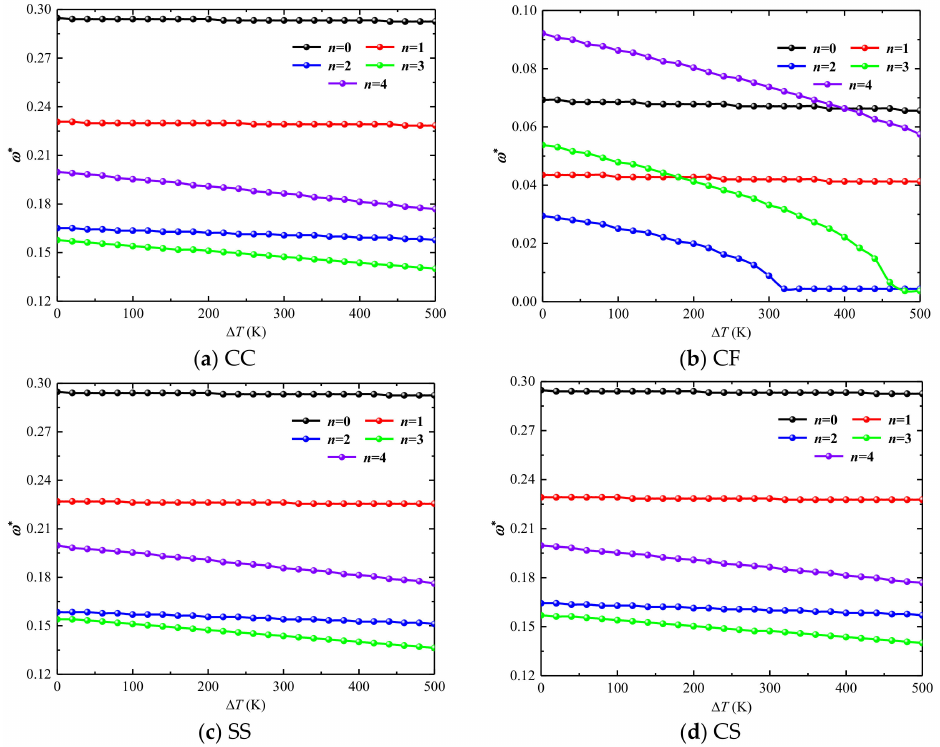
Figure 5. Variation of dimensionless frequencies ω ∗ of non-rotating laminated combined conical- cylindrical shell subjected to thermal effect ( m =